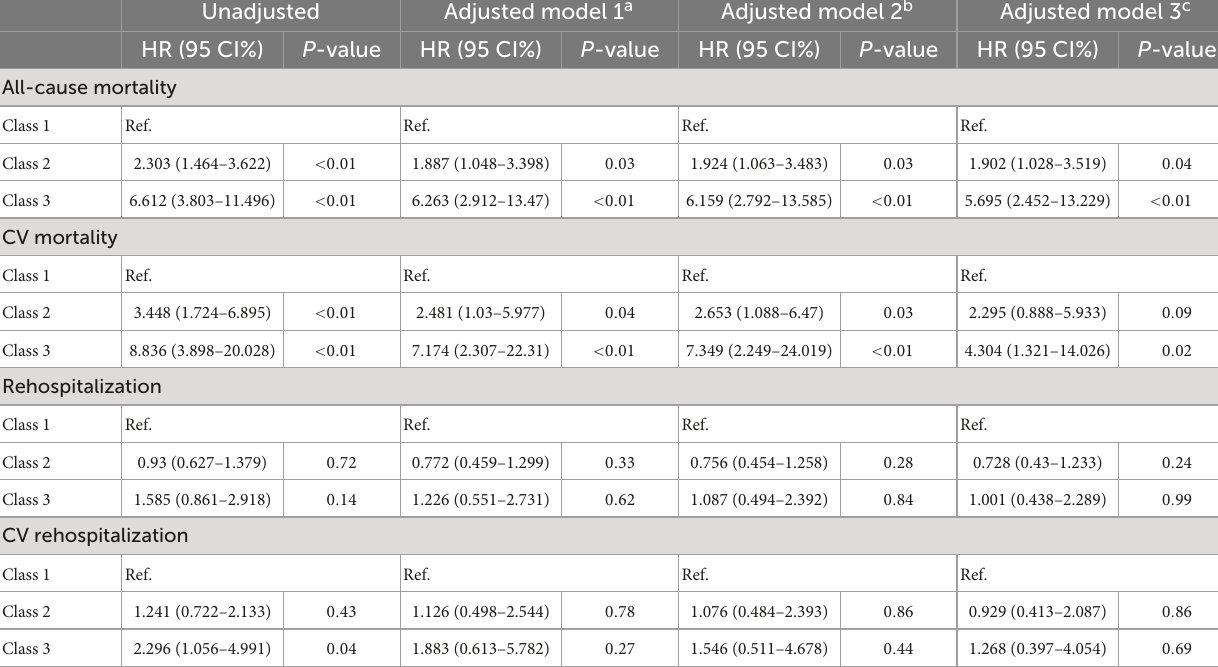
TABLE 4 Association between NT-proBNP trajectories and 5-year outcomes.